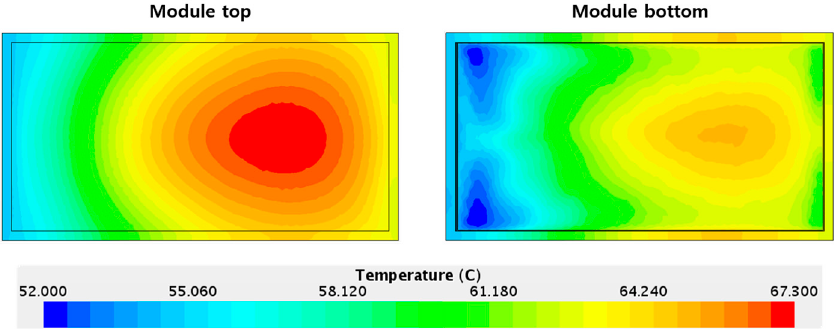
Figure 6. Temperature distribution of the case without cooling.